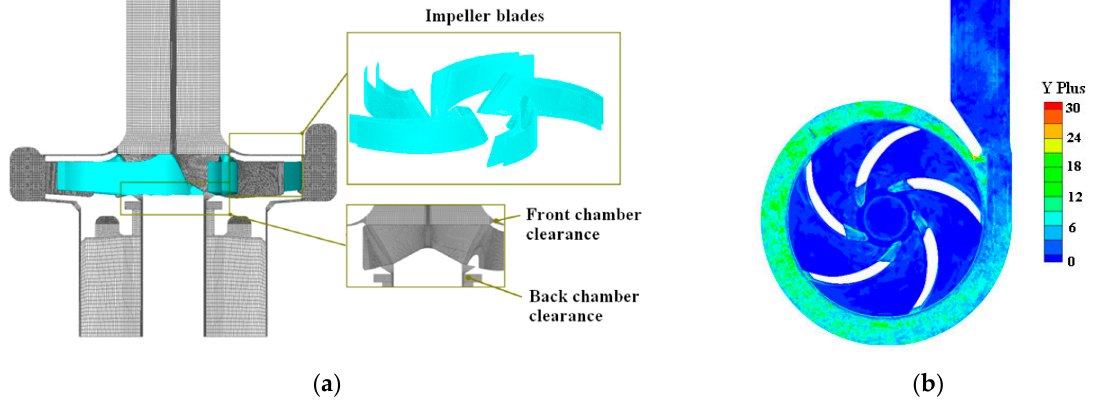
Figure 3. Mesh and wall y+ of the centrifugal pump: ( a ) grid of centrifugal pump; ( b ) wall y+ of the pump.